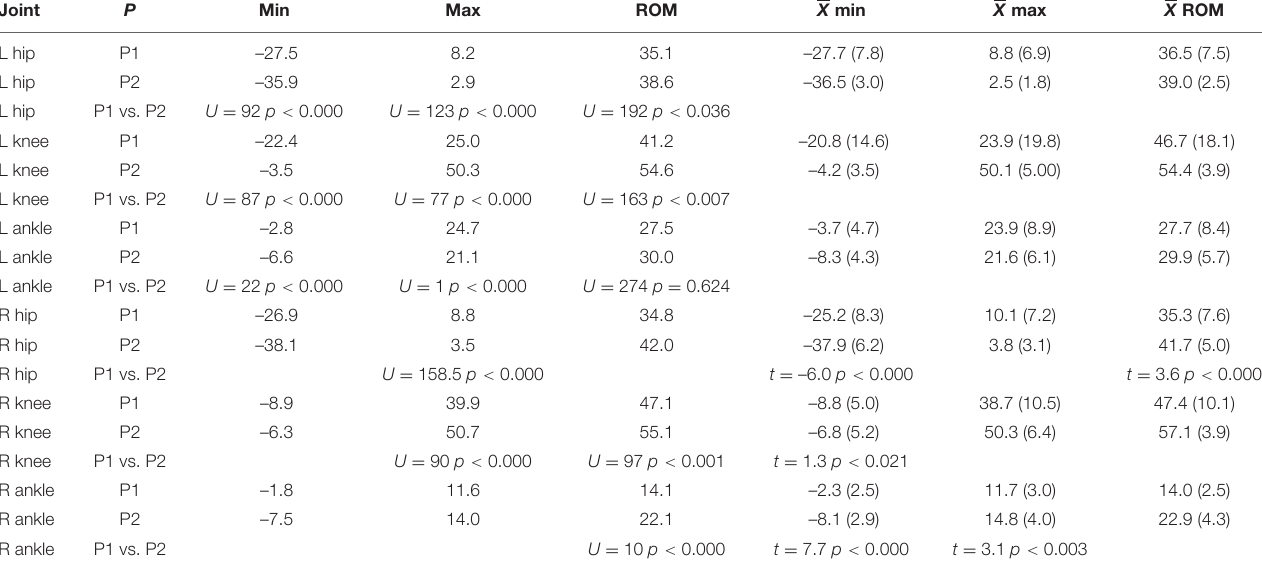
FIGURE 3 | Mean phase portrait area values for each joint and participant. P1’s phase portrait area values are represented by the blue bar graphs; P2 is represented by the black bars. The percentages listed by each comparison provides the percentage increase of P2’s area relative to P1’s area. TABLE 1 | Median of the minimum and maximum joint angle values, as well as ROM for each joint and both